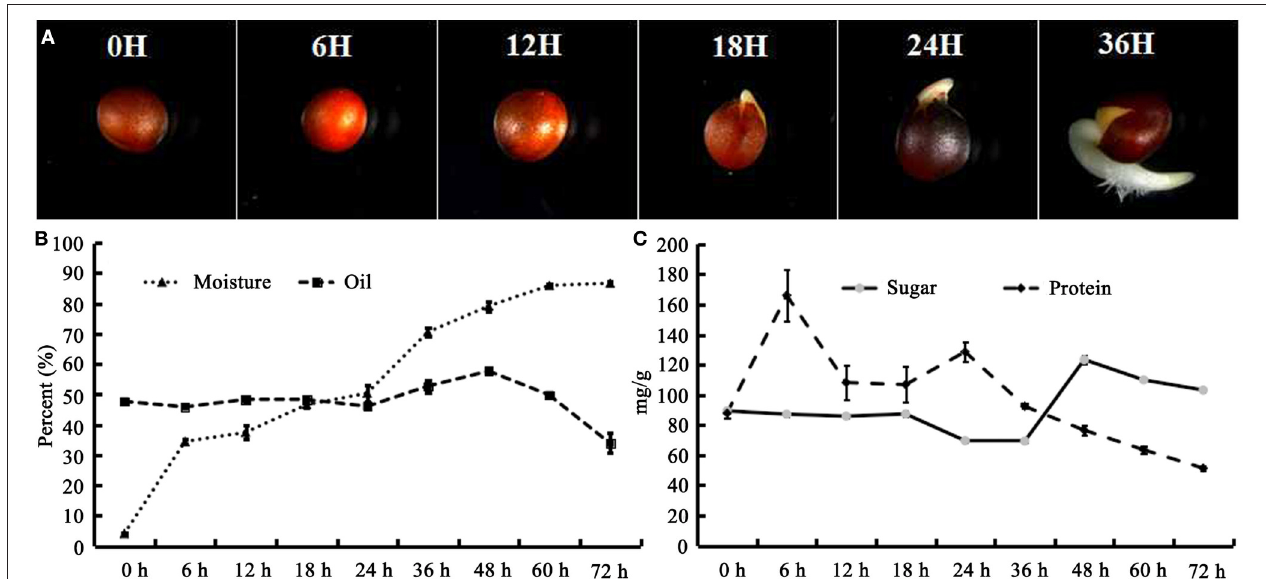
FIGURE 1 | B. napus seed germination process and change of moisture, oil, protein, and sugar during seed germination and seedling establishment. (A) B. napus seed germination. The seeds were imbibed in moisture at 28 ◦ C under dark conditions. Photographs were taken at 0, 6, 12, 18, 24, and 36 HAI; (B) Change of moisture and oil during germination; (C) Change of protein and sugar during germination. Values are means of three biological replicates ( ± SD).